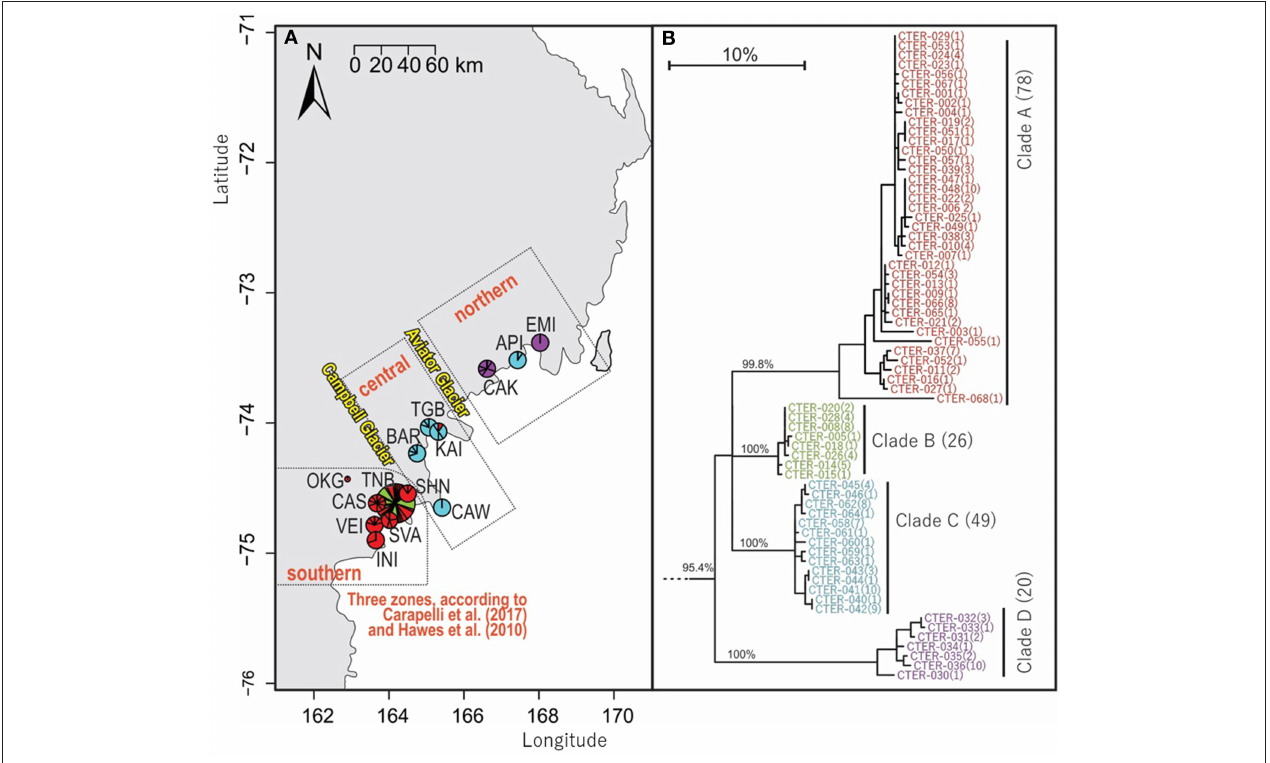
FIGURE 5 | Geographical distribution within northern Victoria Land of COI sequences for Cryptopygus terranovus (CTER; n = 173; 577 bp) showing (A) distributional barriers (Campbell and Aviator Glaciers), and (B) clade groupings as previously suggested by Carapelli et al. (2017) and Hawes et al. (2010). Pie charts are proportionate to the number of sequences, centered at collection site